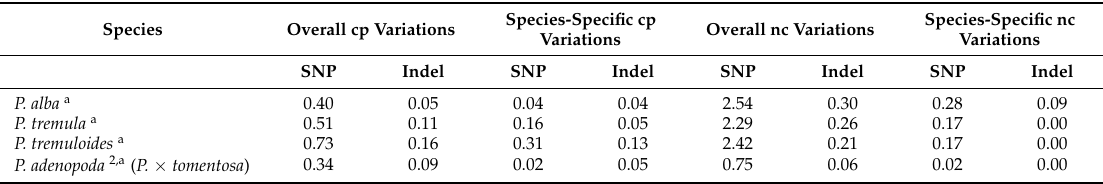
Table 4. Calculation of percent variations. Variations per 100 base pairs (% variation) calculated for the chloroplast and nuclear genome regions, as given in Table 1 (without psb E_ pet L, because it has not been sequenced in all of the species), for the 19 poplar species. cp = chloroplast, nc = nuclear.